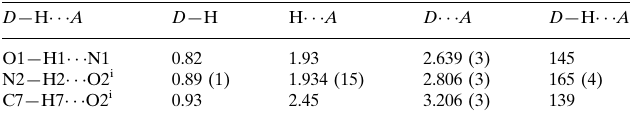
Hydrogen-bond geometry (A˚ , (cid:1)